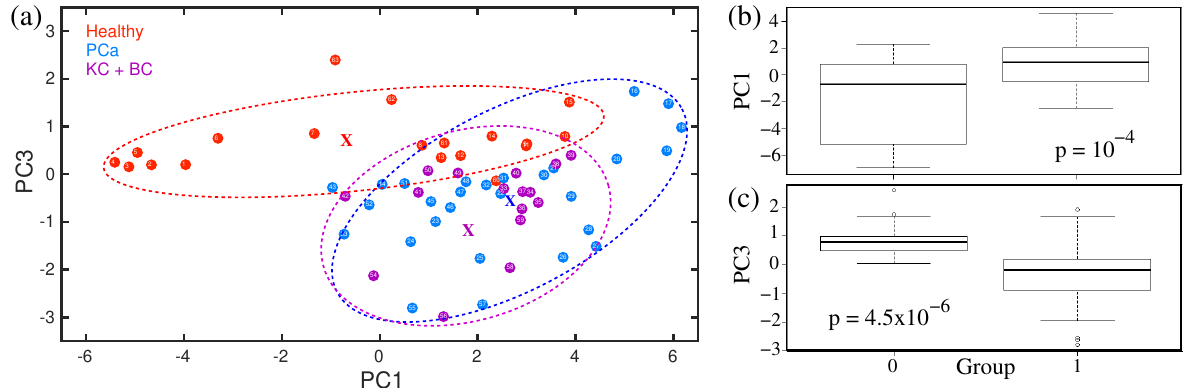
Figure 12. ( a ) Statistical analysis using PCA method. Ellipses are shown for visualization, with the corresponding centres marked by “x”. ( b , c ) The box plots of statistical results.